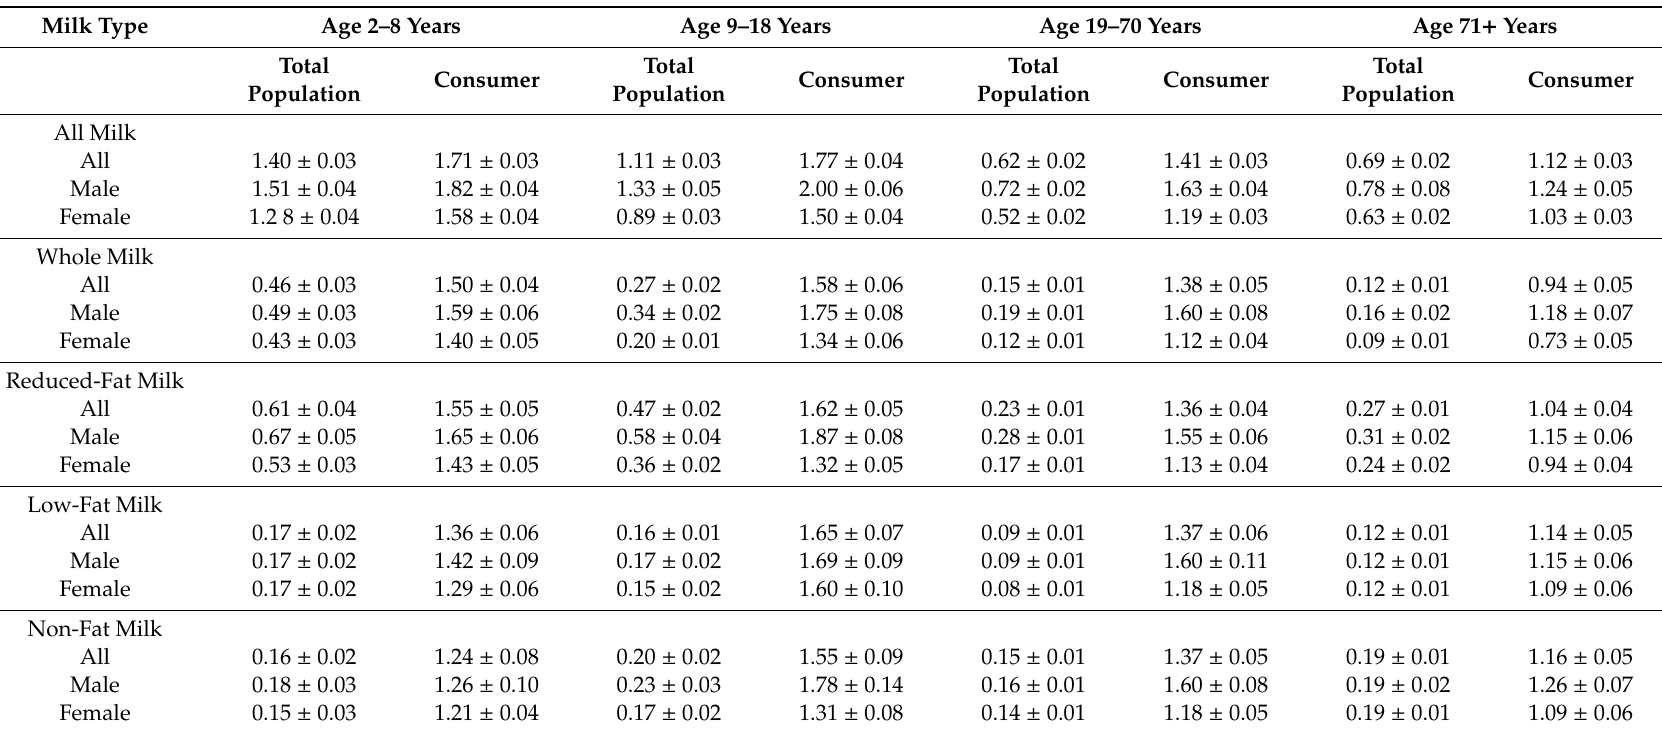
Table 2. Mean intake of milk (cup eq / day) by milk type in di ff erent age and gender groups, NHANES